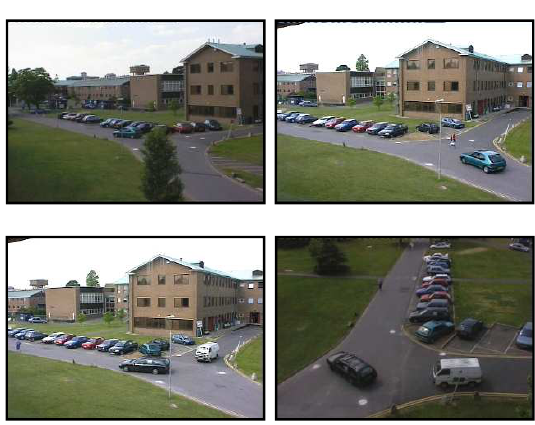
Figure 10: Some videos testing with the camera angles in four different positions